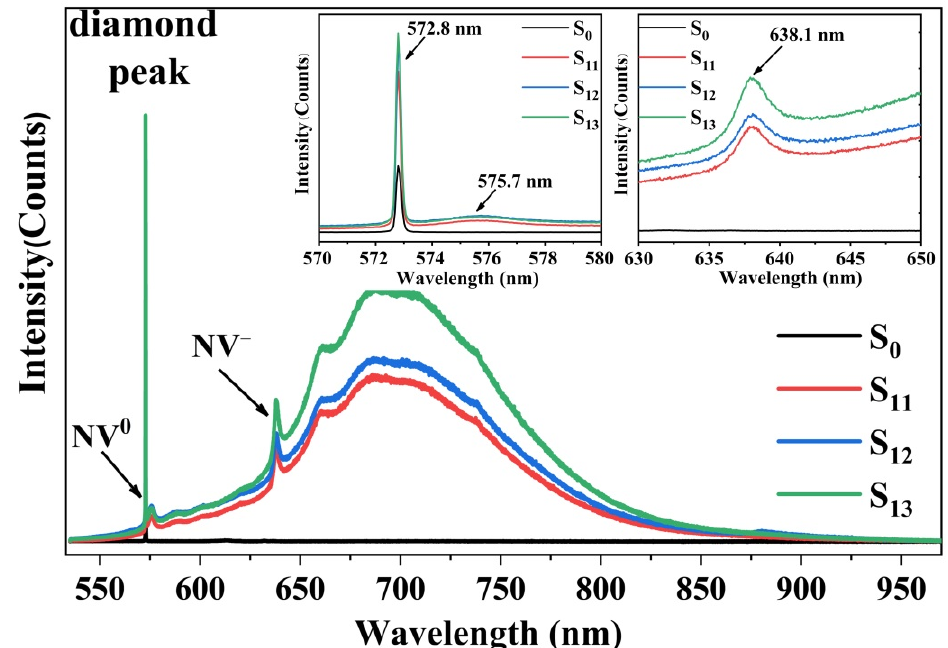
Figure 4. Normalized PL spectra of S 0 , S 11 , S 12 , and S 13 . (The insets show the wavelength ranges of 570–580 and 630–640 nm).